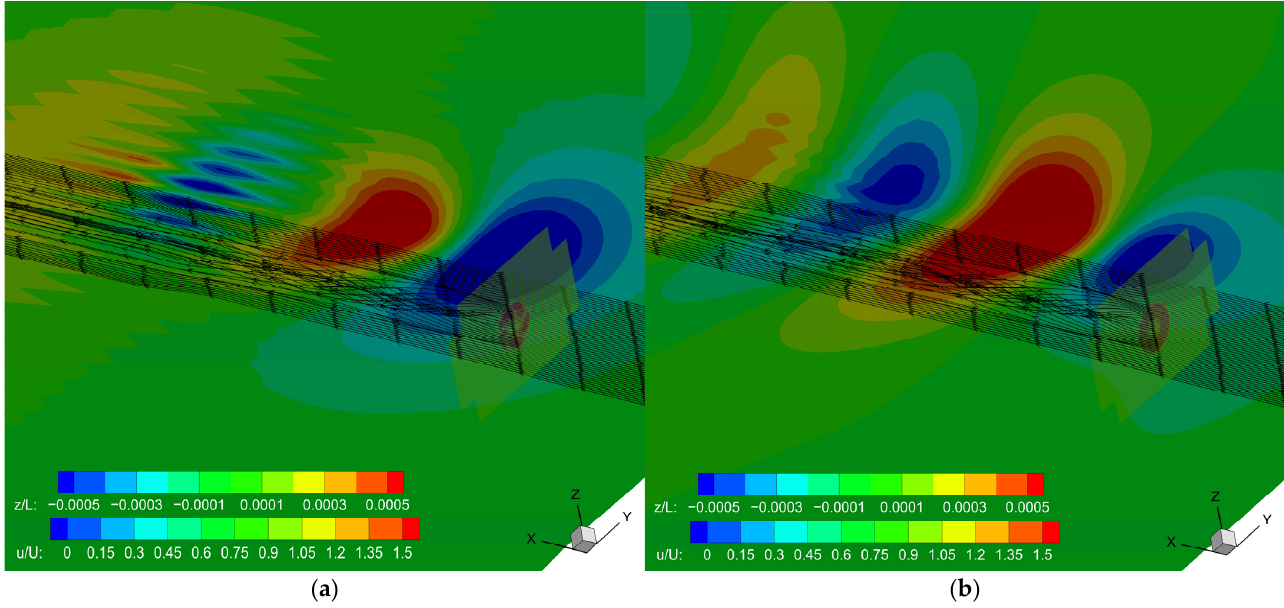
Figure 12. Free surface elevation and streamline ( J = 0.6): ( a ) rotating blade model; ( b ) average model. (The u/U distribution is the slice at propeller plane x/L = 0 and the undisturbed free surface is at z/L = 0)